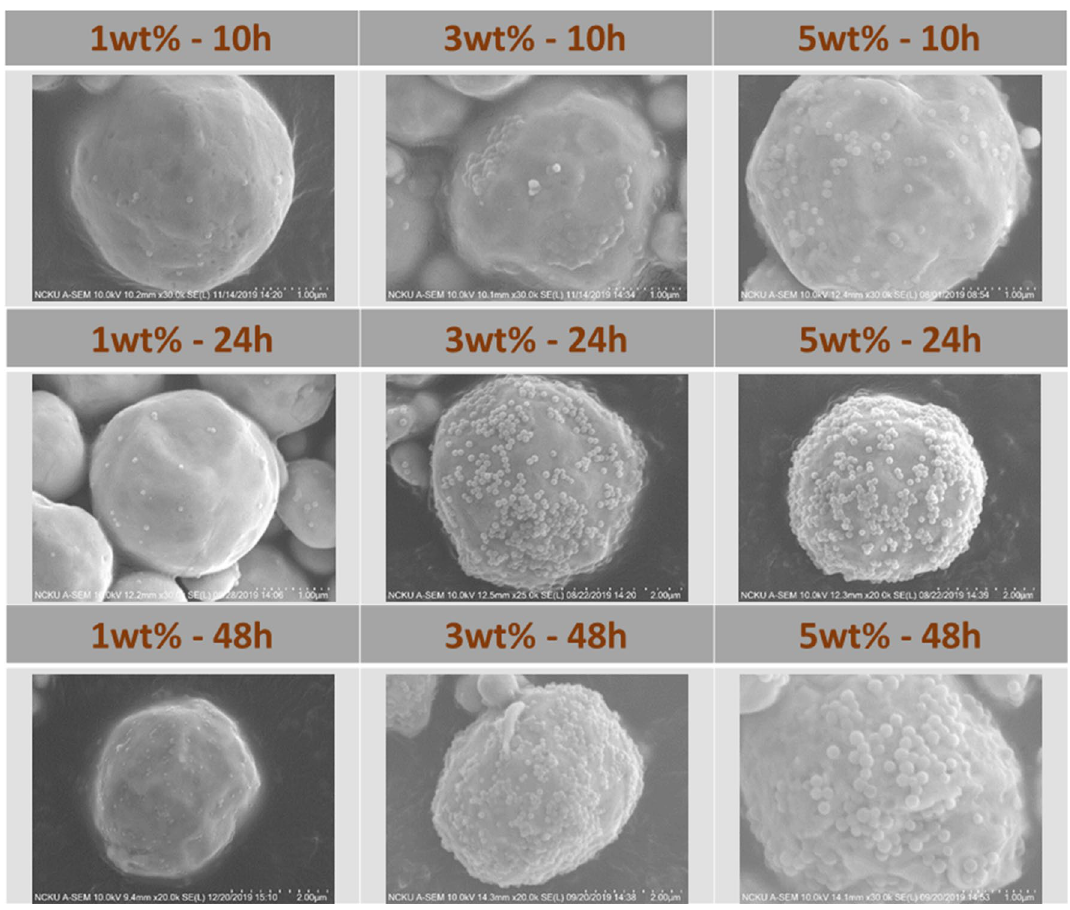
Fig. 3 SEM images of silver powders coated with various amounts of TEOS for various reaction times